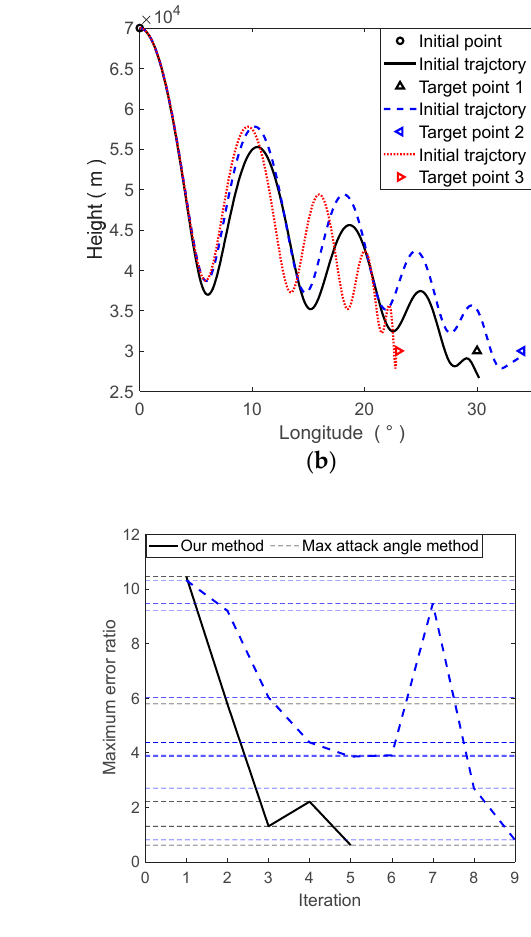
( c ) Figure 7. The grid points and control angle: ( a – c ) are the distributions of the grid points and con- trol angles of case 1,2,and 3, respectively. On the other hand, according to the effect of Figures 6 – 8, all the trajectories can meet the final constraint requirements. In Case 2 and Case 3, the peak values of several con- straints are high due to the avoidance of the no-fly zones, especially at low flight alti- tudes. In order to effectively meet the constraints, at the initial stage of flight, the vehicle usually employs a high attack angle. In case 3, in order to pass through and between the no-fly zones and increase the range, a smaller attack angle value is adopted; The change of the corresponding bank angle represents the avoidance maneuver process of the ve- hicle. In Case 1, there are no no-fly zones, so the change of the bank angle is small; However, in Case 2 and Case 3, considering the influence of no-fly zones, there are many variation of the bank angle; this can be seen from the grid point changes when the uni- form grid points are used in the initial trajectory. For the last iteration trajectory, due to the small aerodynamic force in the initial stage of vehicle, where the nonlinear illegal degree is low, and the grid points are relatively sparse; at the end of flight, the flight